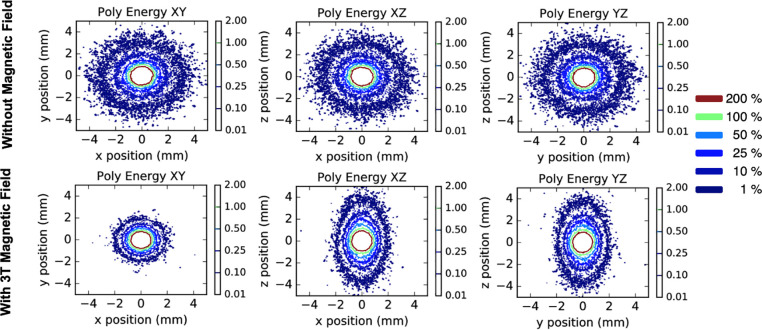
Poly-energetic electron source in a homogeneous lung environment.Normalized dose distributions in a homogeneous lung-tissue phantom for a poly-energetic electron source. Results are shown in absence of a magnetic field (top row), and under the presence of a 3 T magnetic field (bottom row) oriented on the positive z-axis. Simulations are limited to ± 5 mm regions in their corresponding planes.